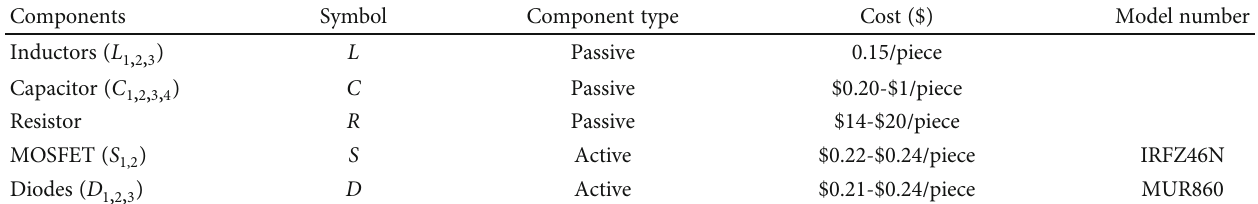
Table 2: Component type and cost.